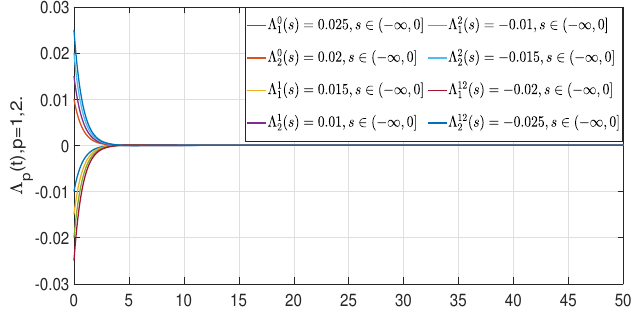
Figure 4. Curves of y 0 different initial values; ( b ) y 1 with different initial values.